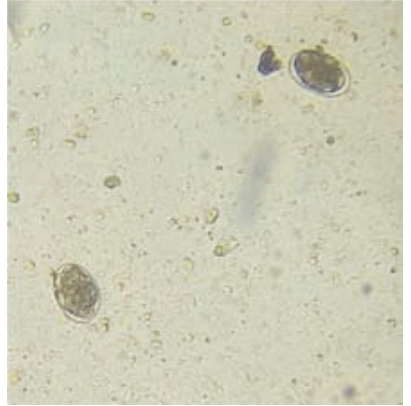
Fig.2. Ova of Ancylostoma caninum by direct faecal sample examination